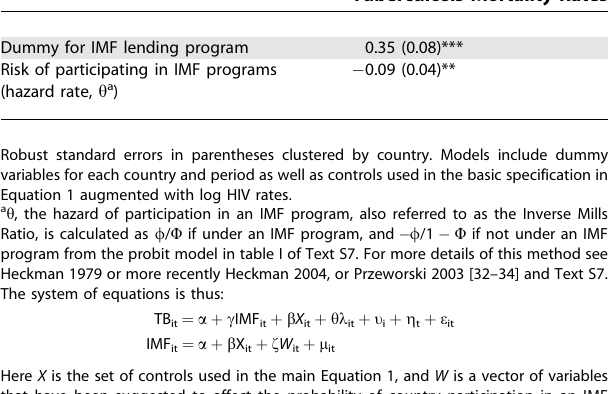
Table 6. Associations of IMF Programs with Log Tuberculosis Mortality Rates, Adjusted for Selection Bias